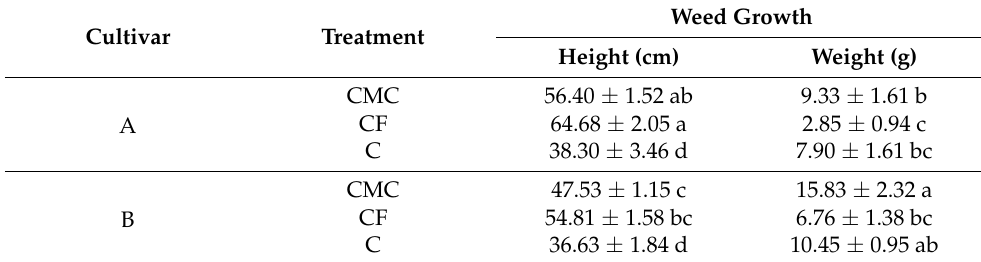
Table 2. Growth performance of weeds in non-mulch treatments.